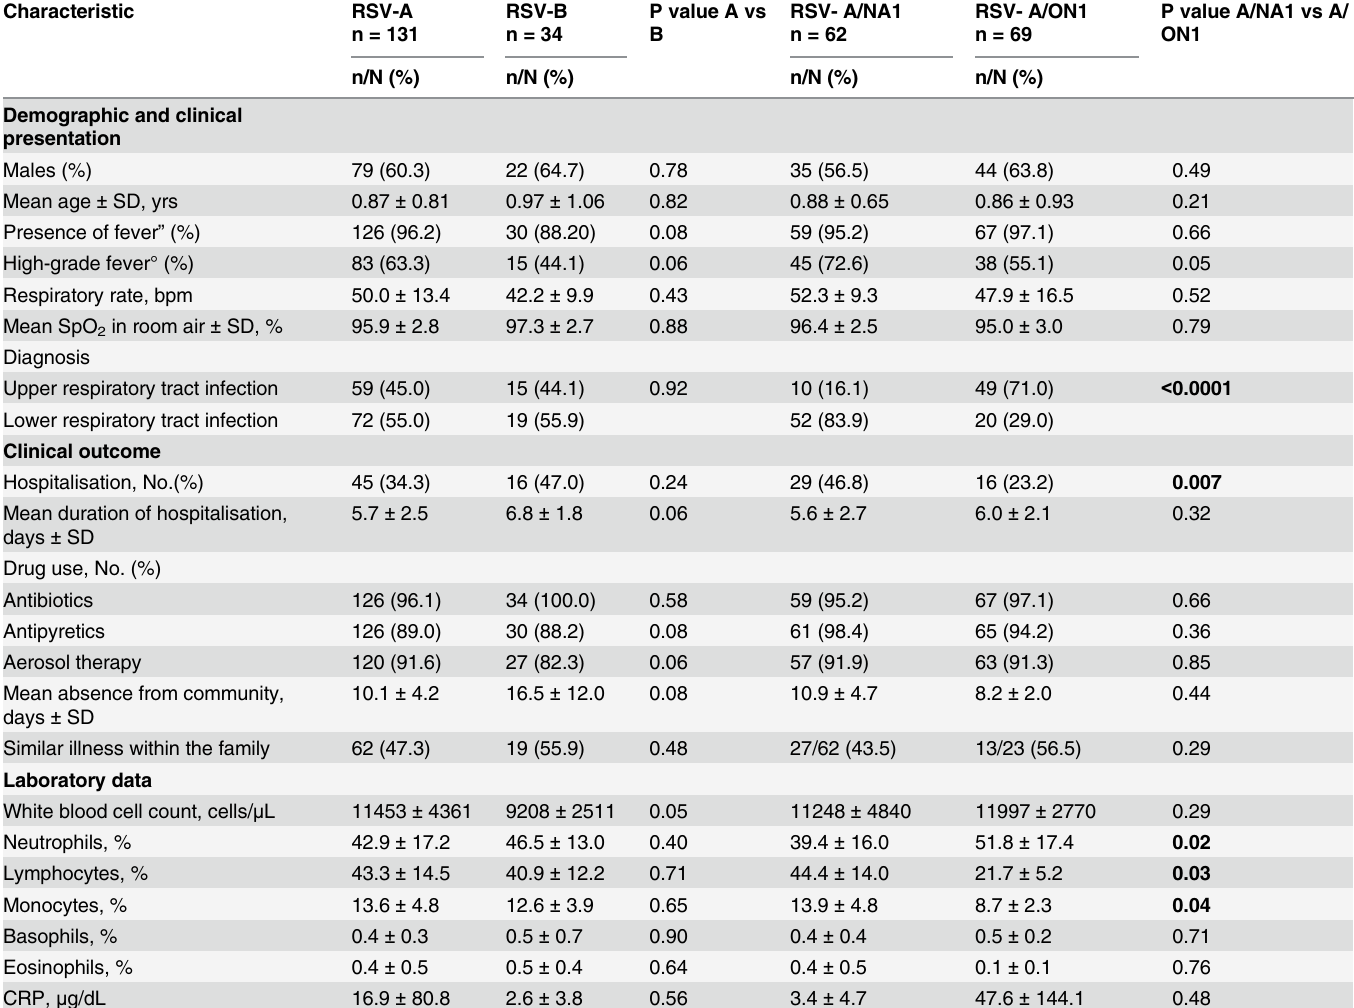
Table 4. Comparison of individual RSV infections by demographic, clinical and laboratory